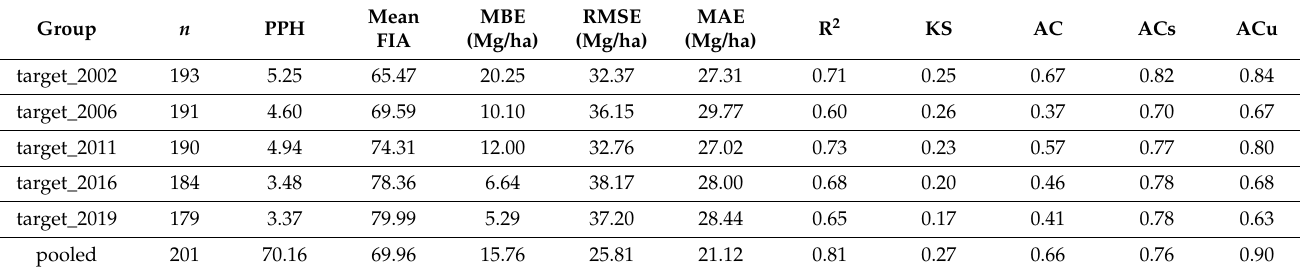
Table 4. Agreement statistics (SI-corrected)—78,100 Ha Hex.